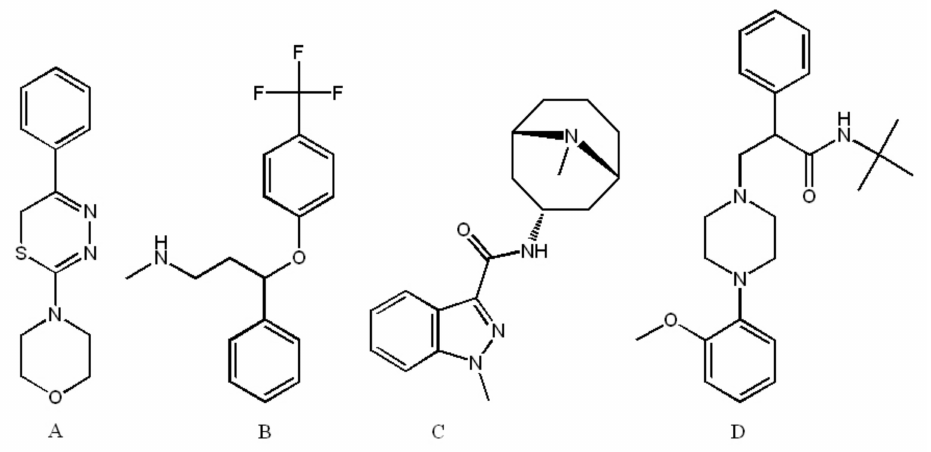
Figure 1. Structural chemical formulas of 2-morpholino-5-phenyl-6H-1,3,4-thiadiazine, hydrobro- mide: (L-17) ( A ), the SSRI fluoxetine ( B ), 5-HT 3 receptor antagonist granisetron ( C ), and 5-HT 1A receptor antagonist WAY100135 ( D